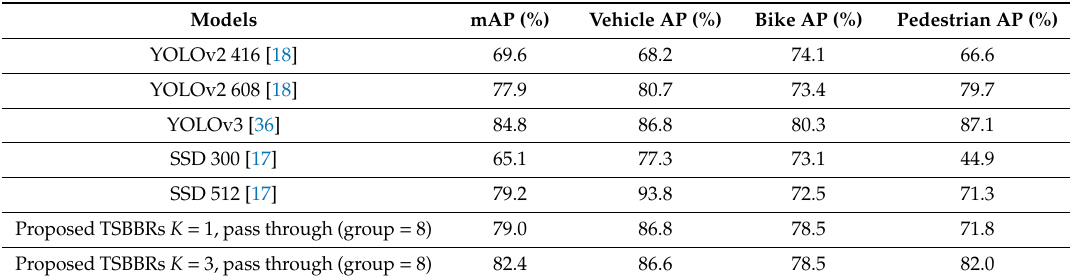
Table 12. Comparison of the proposed design to other models on the iVS